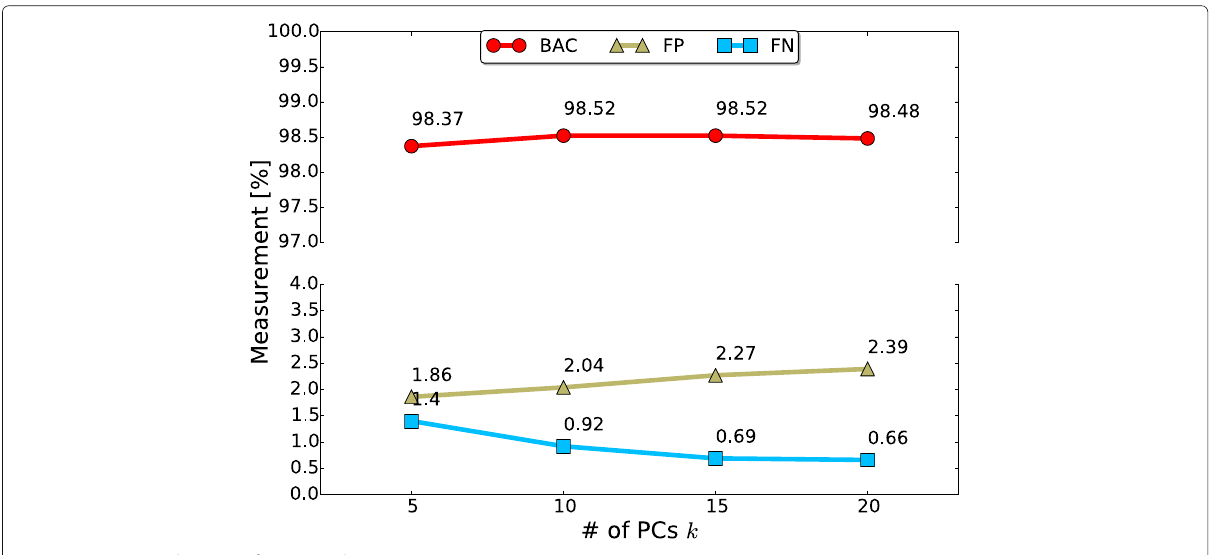
Fig. 13 BAC, FP, and FN rates for various